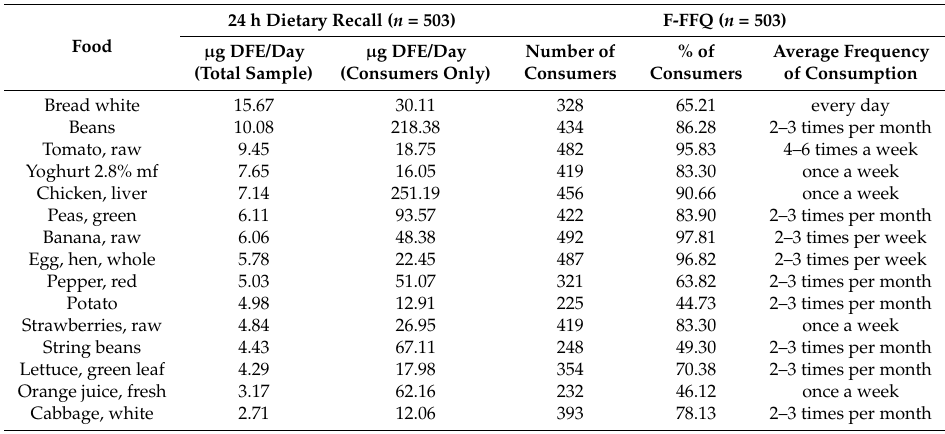
Table 3. Major folate food sources assessed by the F-FFQ and 24 h dietary recalls among Serbian women of reproductive age. 24 h Dietary Recall ( n = 503) Food Bread